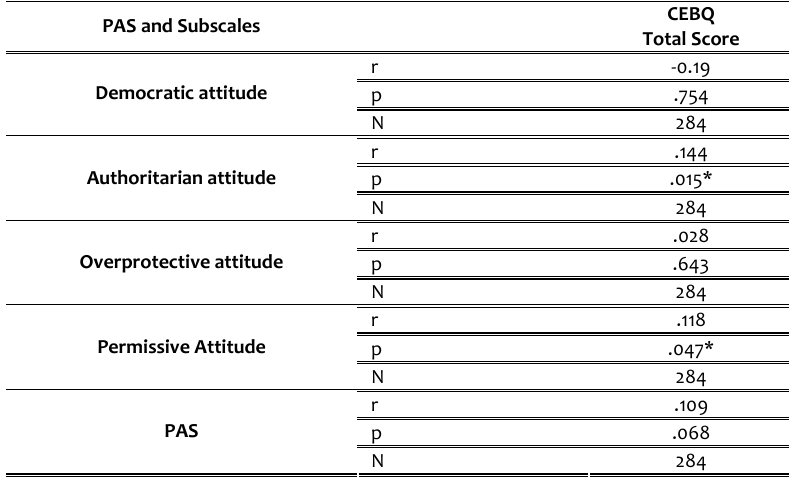
Table 10. Results of correlation analysis about the correlations between the Parenting Attitude Scale subscale scores of the children and the children’s eating behaviors PAS and Subscales